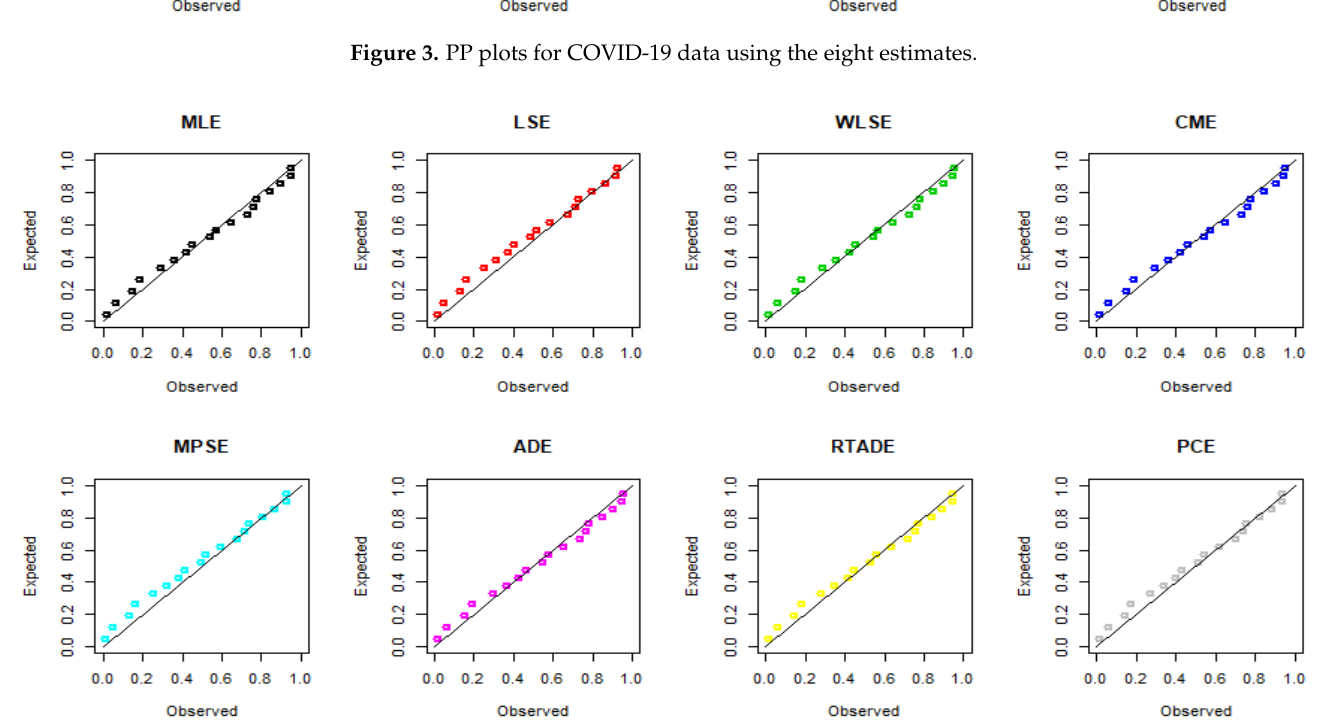
Figure 4. PP plots for remission times data using the eight estimates.